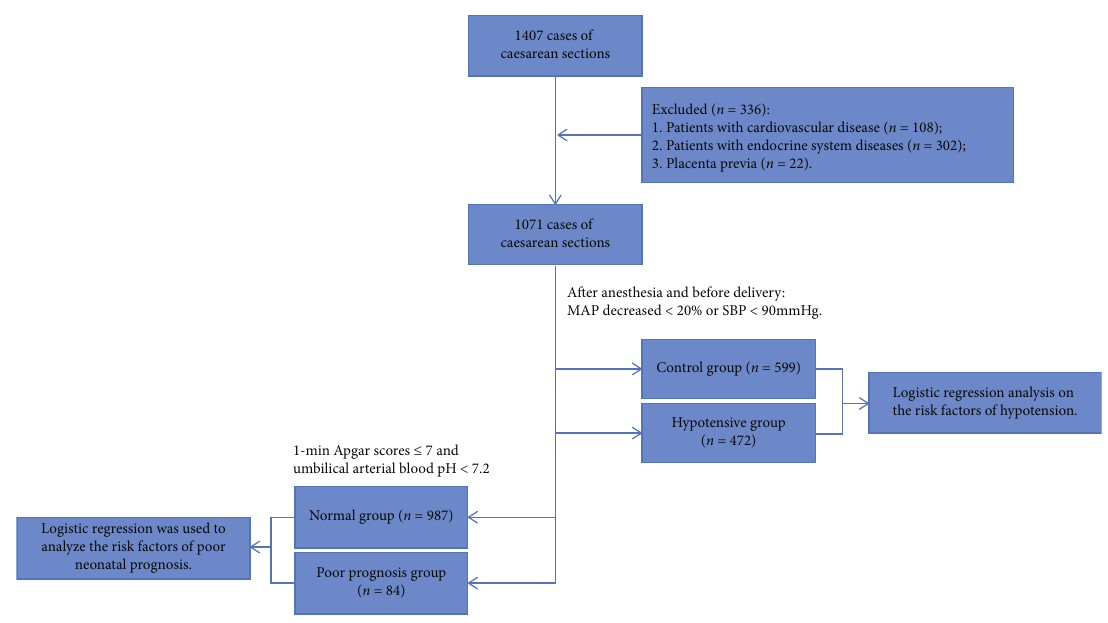
Figure 1: Flow chart of this